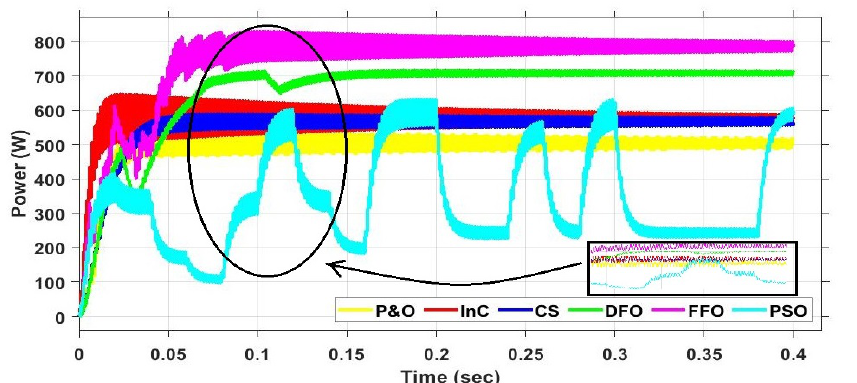
Figure 16. PS2 power comparison between all algorithms for centralized PV system.